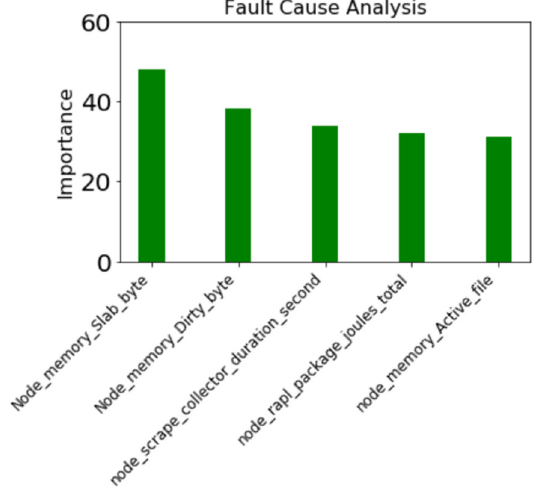
Figure 15. Feature Importance Result.